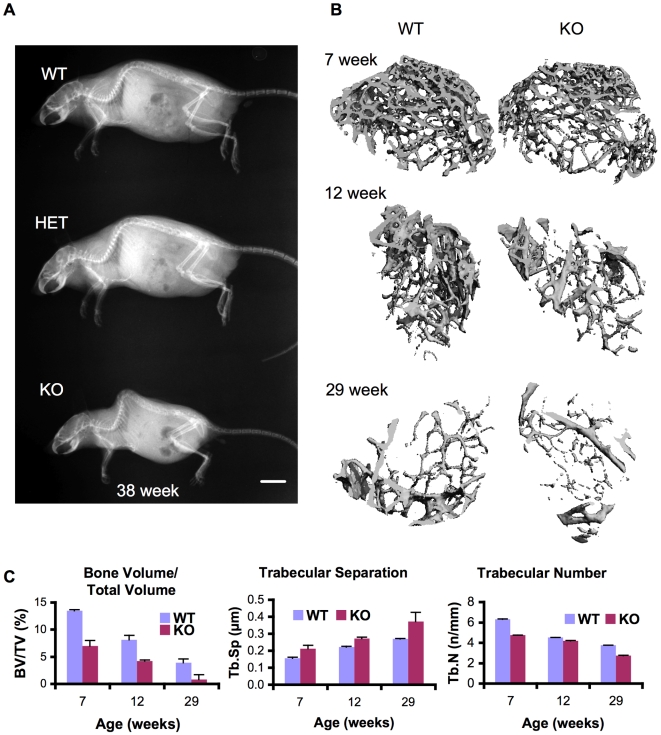
Abnormal bone in CypB–knockout mice.(A) Total body radiographs of 38-week-old mice. Note the enhanced curvature of the spine in the Ppib−/− mouse. Bar = 1 cm. (B) 3D reconstruction of slices from micro CT analysis of femurs from CypB knockout and littermate control mice. (C) Bone volume/total volume, trabecular separation, and trabecular number in femurs analyzed by microCT at the indicated ages.